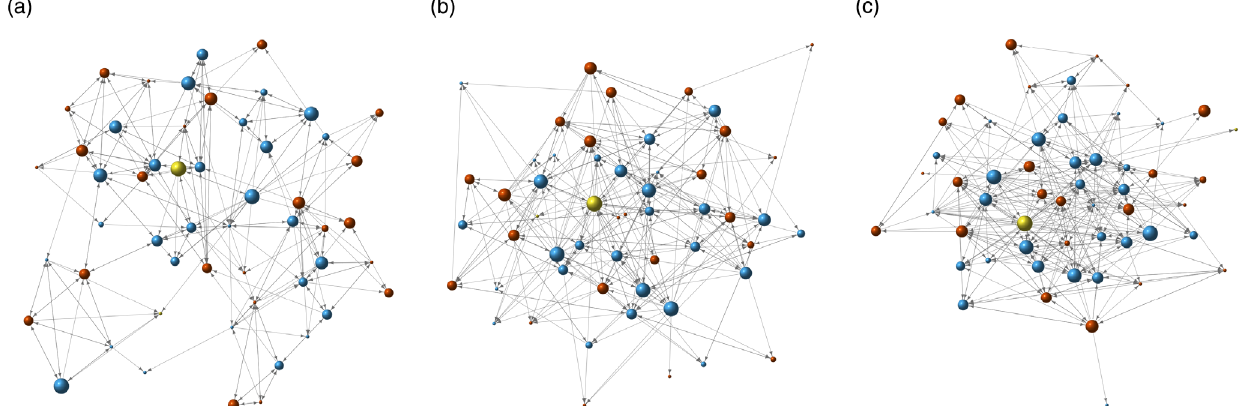
FIG. 5. The in-class network evolution for individual networks in section A ( N ¼ 53 ) with node size representing the outdegree from the fourth collection ( α ¼ 0 . 0 ) and the color indicating the direction of the shift in anxiety scores (orange: decrease; blue: increase; yellow: no shift). The networks include only students. (a) First collection; (b) fourth collection; (b) fifth collection.